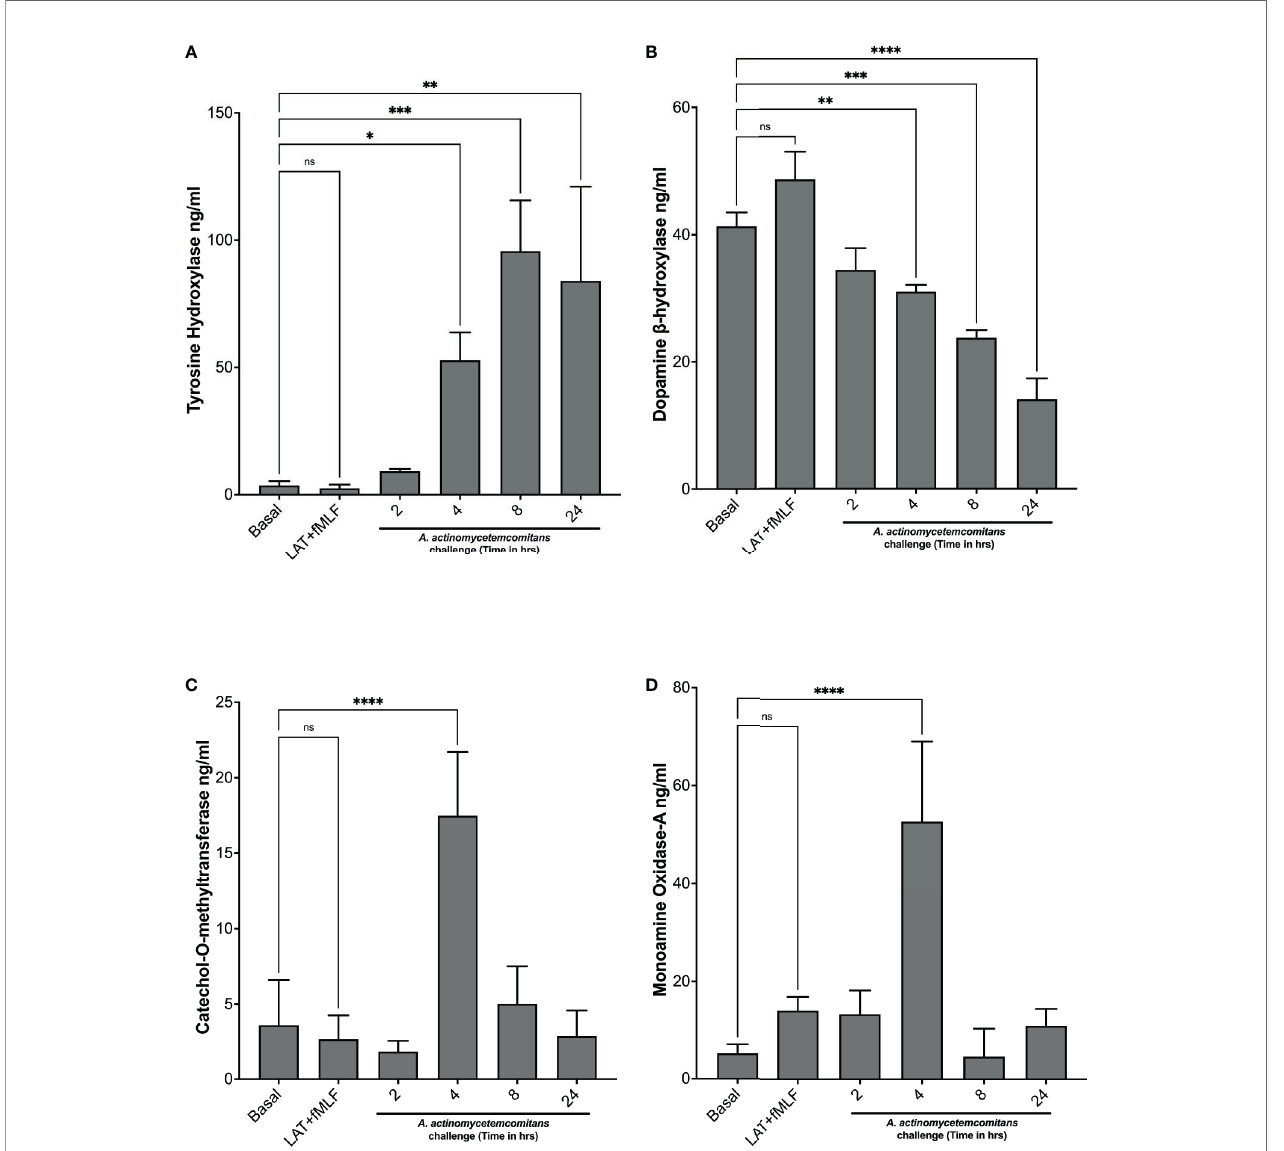
FIGURE 2 | A. actinomycetemcomitans promotes increased levels of enzymes involved in catecholamine metabolism in human neutrophils. Human neutrophils were challenged with A . actinomycetemcomitans (MOI 50) for 2 h, 4 h, 8 h and 24 h; cell lysates were collected, and the levels of tyrosine hydroxylase (A) , dopamine b - hydroxylase (B) , catechol-O-methyltransferase (C) , and monoamine oxidase A (D) were measured by ELISA. Enzyme levels are plotted as the mean ± SD of three independent experiments. Statistical differences among experimental conditions and time points were analyzed by repeated measures one-way ANOVA, followed by Tukey ’ s post-test. ns, not signi fi cant, * p < 0.05, ** p < 0.01, *** p < 0.001, **** p <